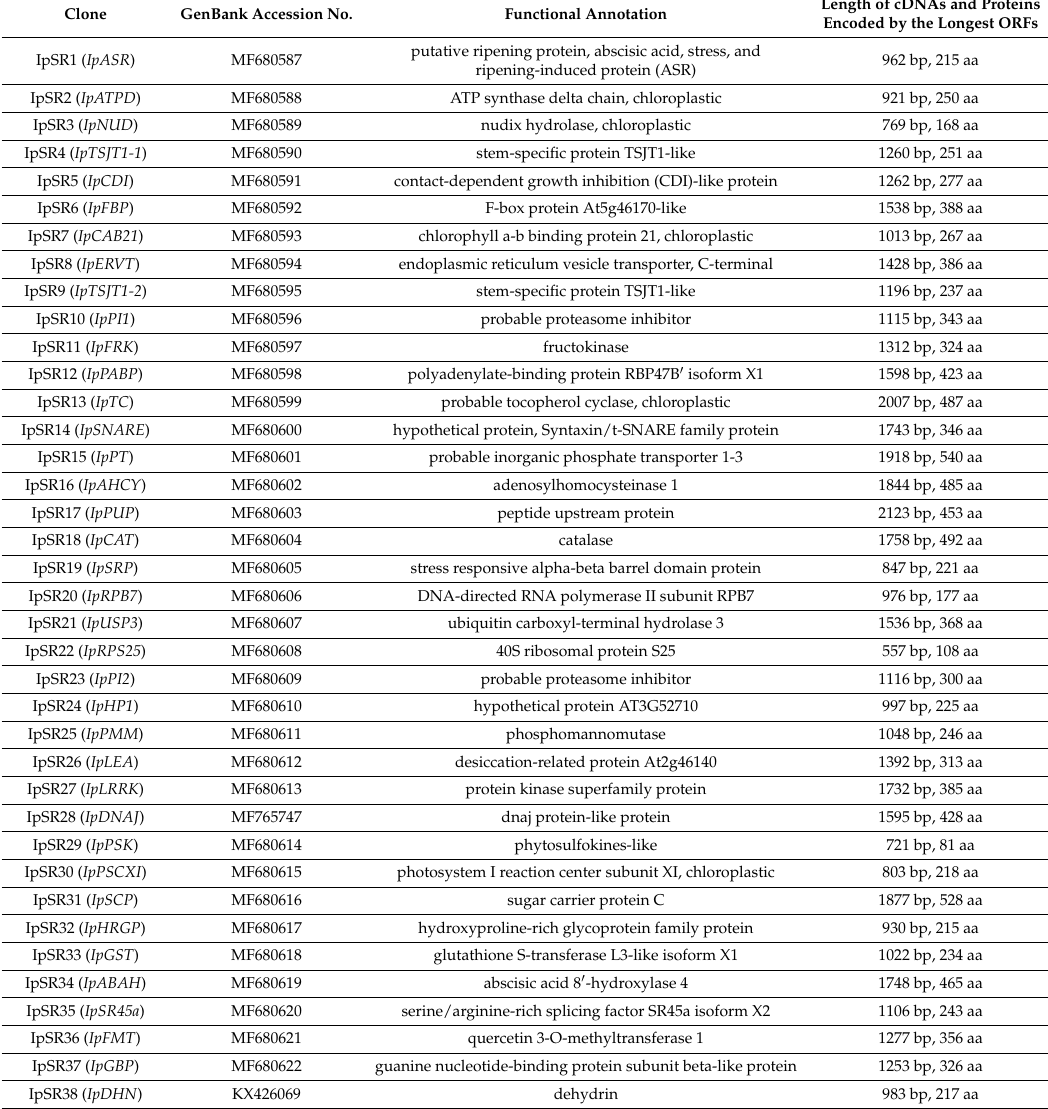
Table 1. Annotation of 38 full-length IpSRs obtained from the yeast functional screening assay. Clone GenBankAccessionNo. Functional Annotation Length of cDNAs and Proteins Encoded by the Longest ORFs MF680587 putative ripening protein, abscisic acid, stress, and ripening-induced protein (ASR) 962 bp, 215